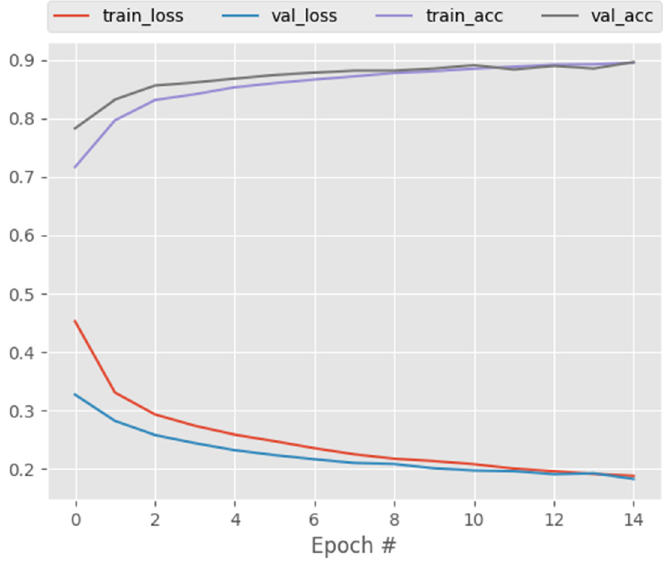
Figure 15. DenseNet121 training and validation performance for X-ray images.